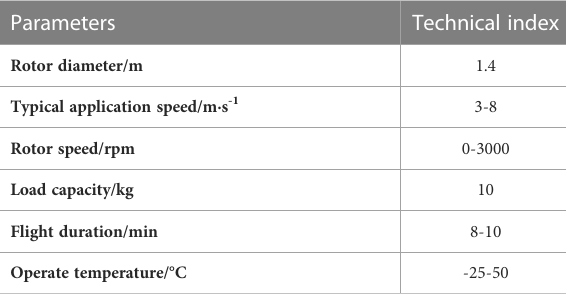
TABLE 1 Parameters of the quadrotor plant protection